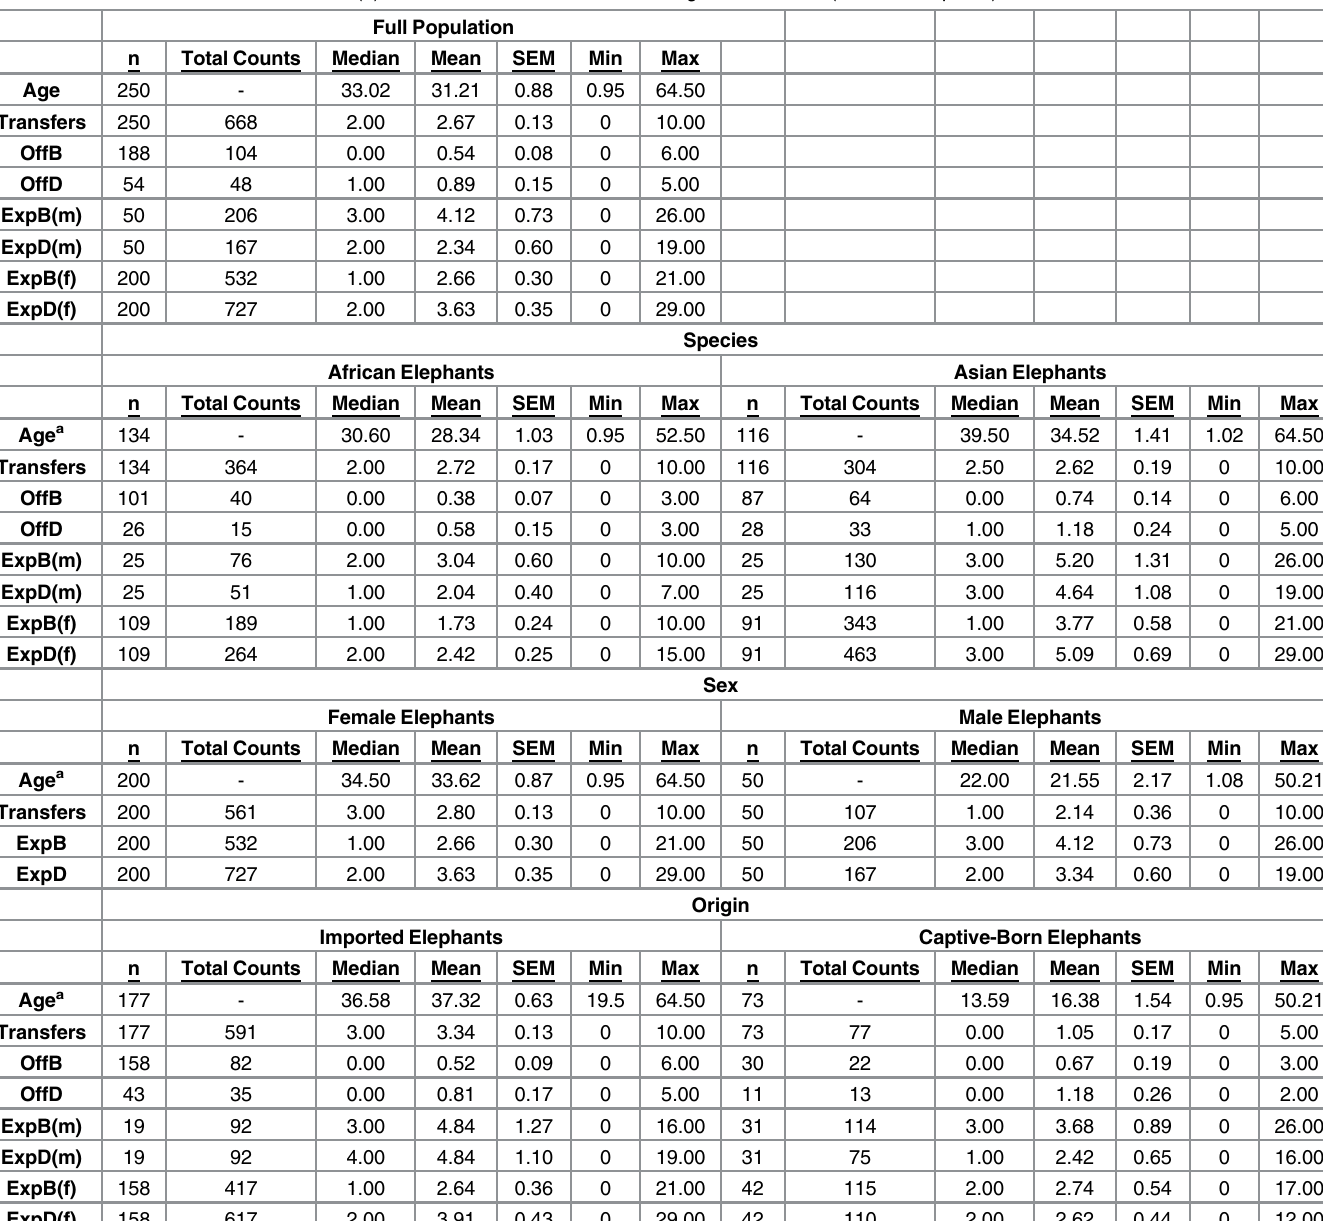
Table 3. Summary of life events and age (as of 7/1/2012) for the full population (n = 250) by species, sex and origin. Data include the number of ele- phants that were included in each variable (n), and the number of events, including median, mean (# events/elephant), SEM, minimum and